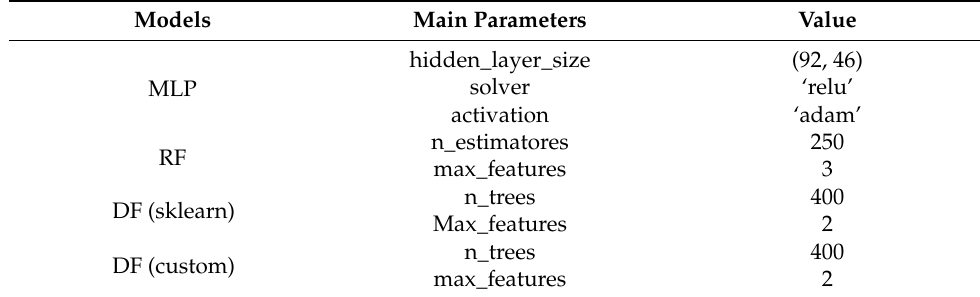
Table 2. Main parameters of MLP, RF, DF (sklearn), and DF (custom).